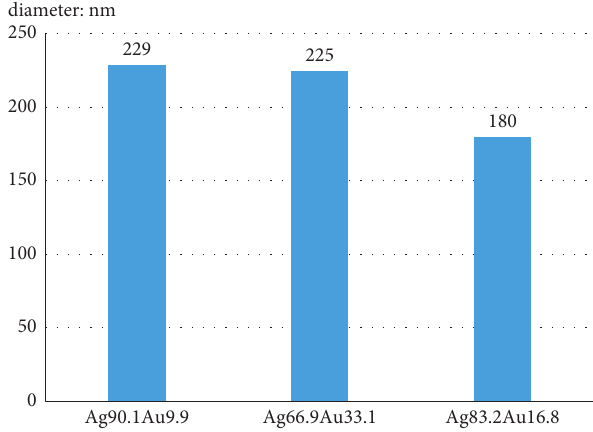
Figure 2: Average size of products of Ag + /Au III at different molar ratios.